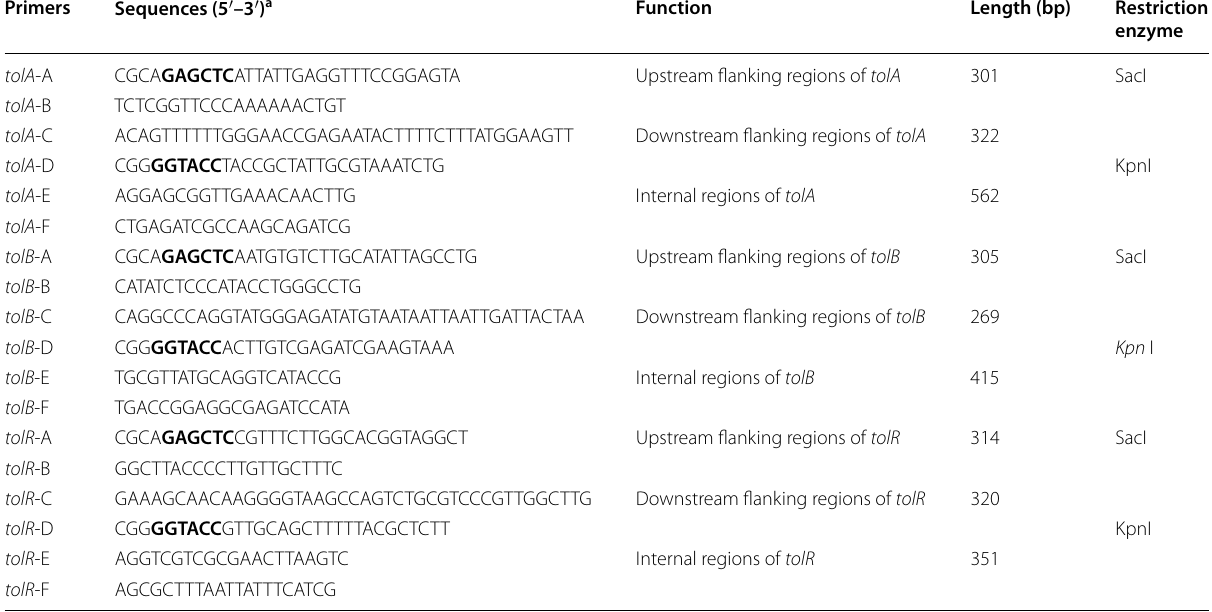
a Bold nucleotides denote enzyme restriction sites